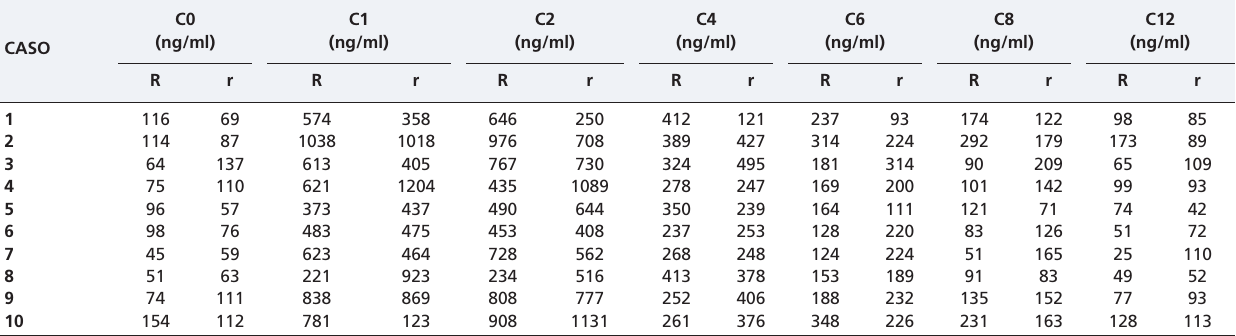
Table 3 - CSA-PK parameters in 10 INS patients during remission and relapse.